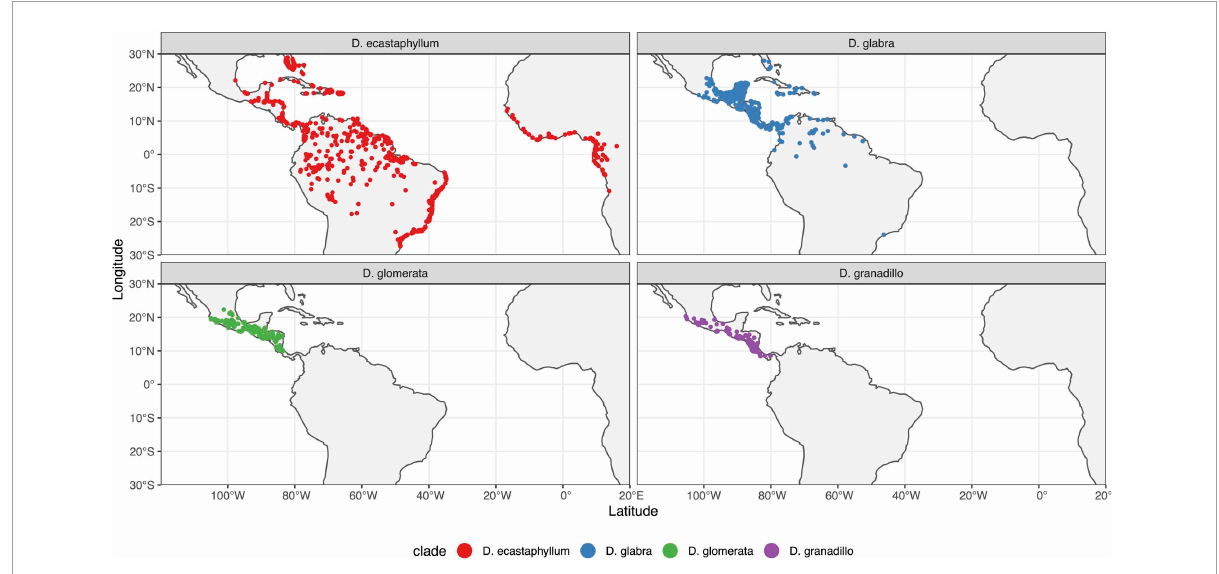
FIGURE5 Distribution maps by clade for Dalbergia species from Mexico, Central America, and the Caribbean.